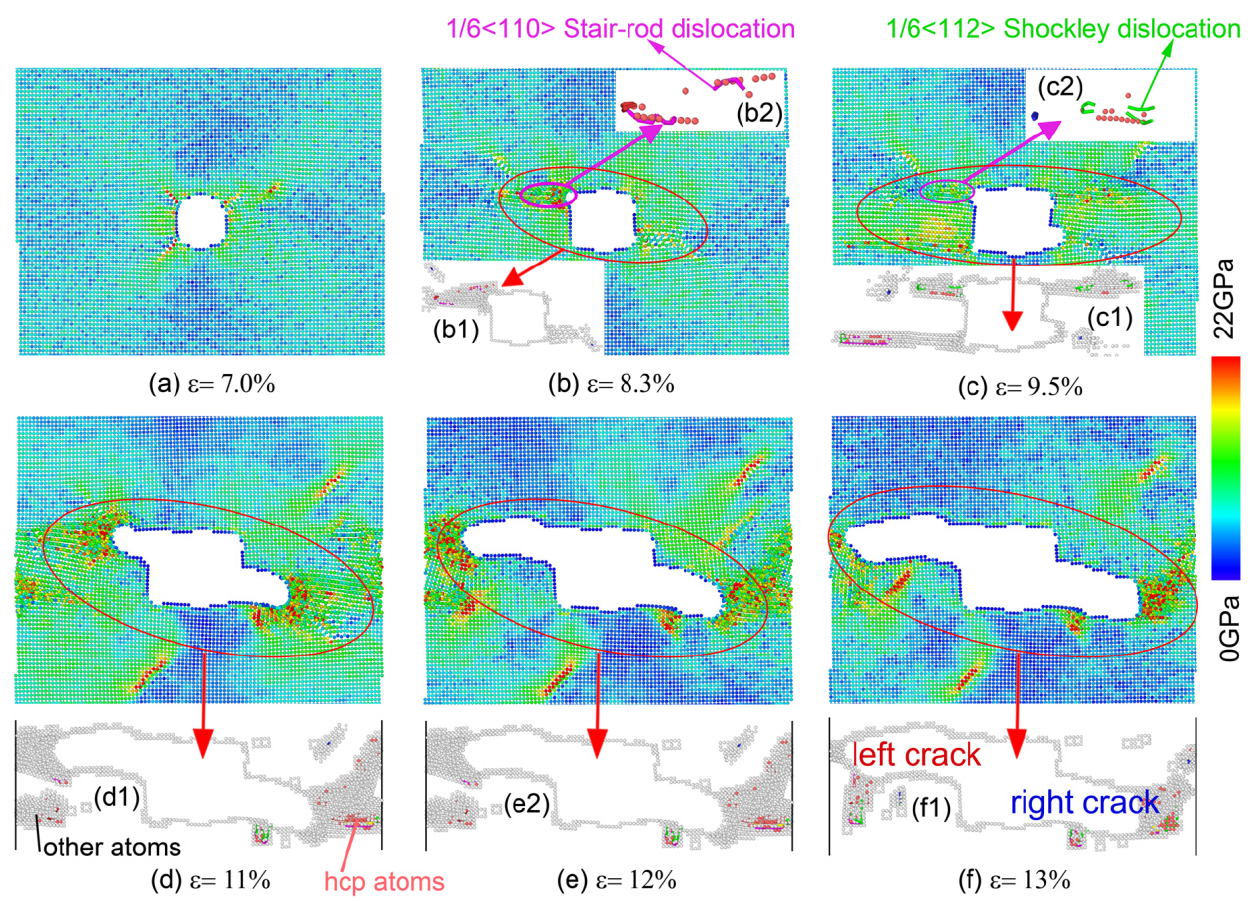
Figure 5. The contour plots of the atomic tensile stress field and crack growth states at different tensile strains (EAM/FS potential).